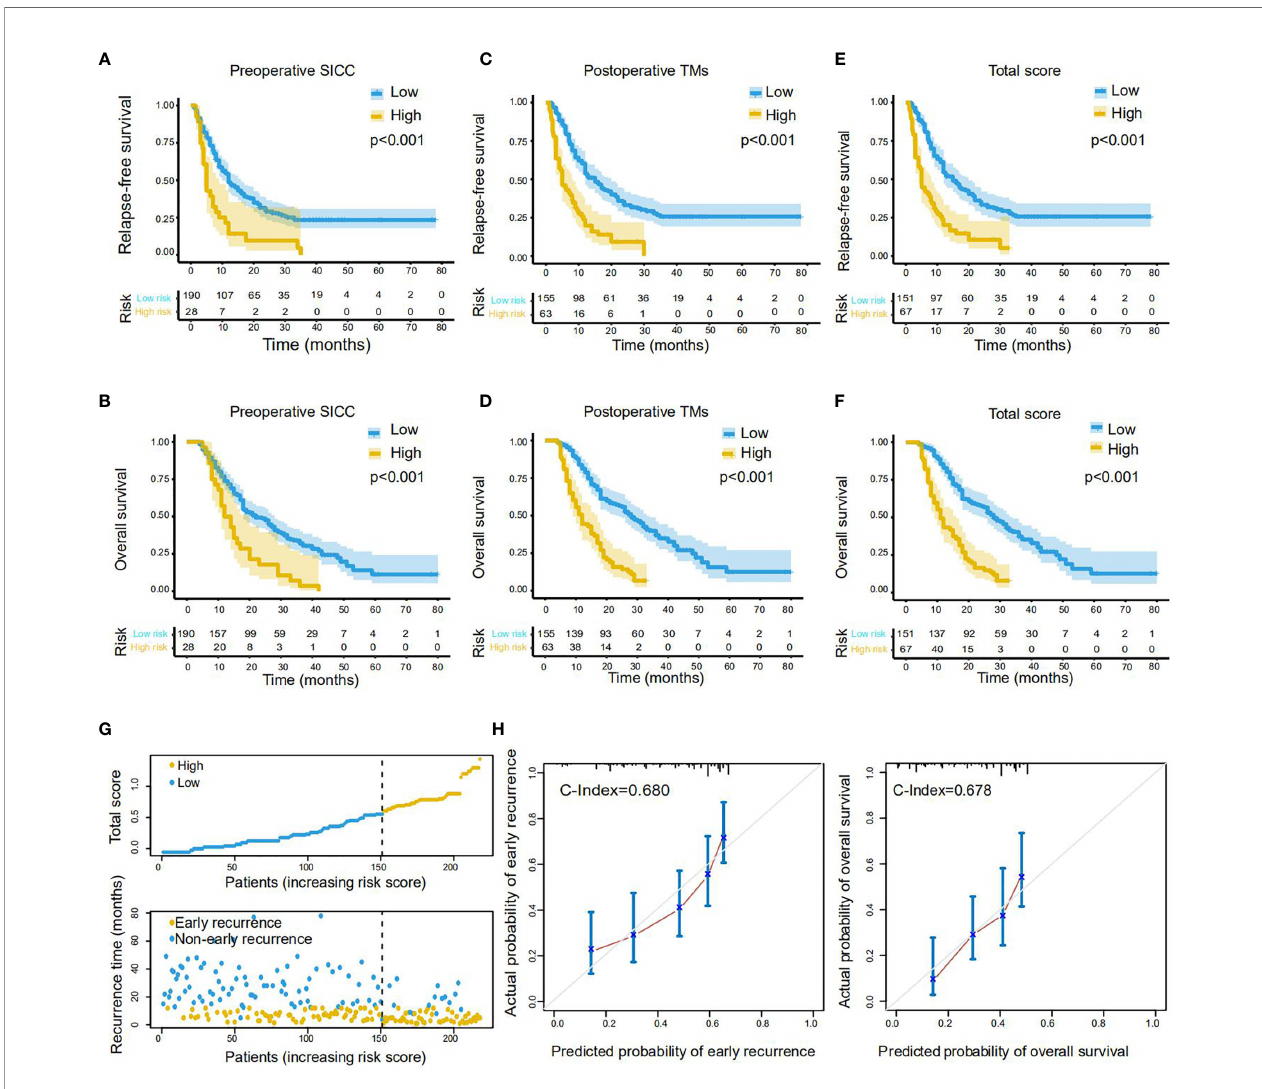
FIGURE 3 | Performance of the scoring systems on RFS and OS prediction in the training cohort. (A, B) The Kaplan-Meier survival curves of RFS (A) and OS (B) for PDAC patients with low or high preoperative SICC (Value cutoff = 0.4). (C, D) The Kaplan-Meier survival curves of RFS (C) and OS (D) for patients with low or high postoperative TMs (Value cutoff = 0.6). (E, F) The Kaplan-Meier survival curves of RFS (E) and OS (F) for patients with low or high total score (Value cutoff = 0.6). (G) Distribution of the total score and related recurrence data in the training cohort. (H) Calibration plot for the internal validation of the total score on RFS (left) and OS (right) evaluation. The Y-axis represents the actual rate. The X-axis represents the predicted rate. Each cutoff value was calculated via